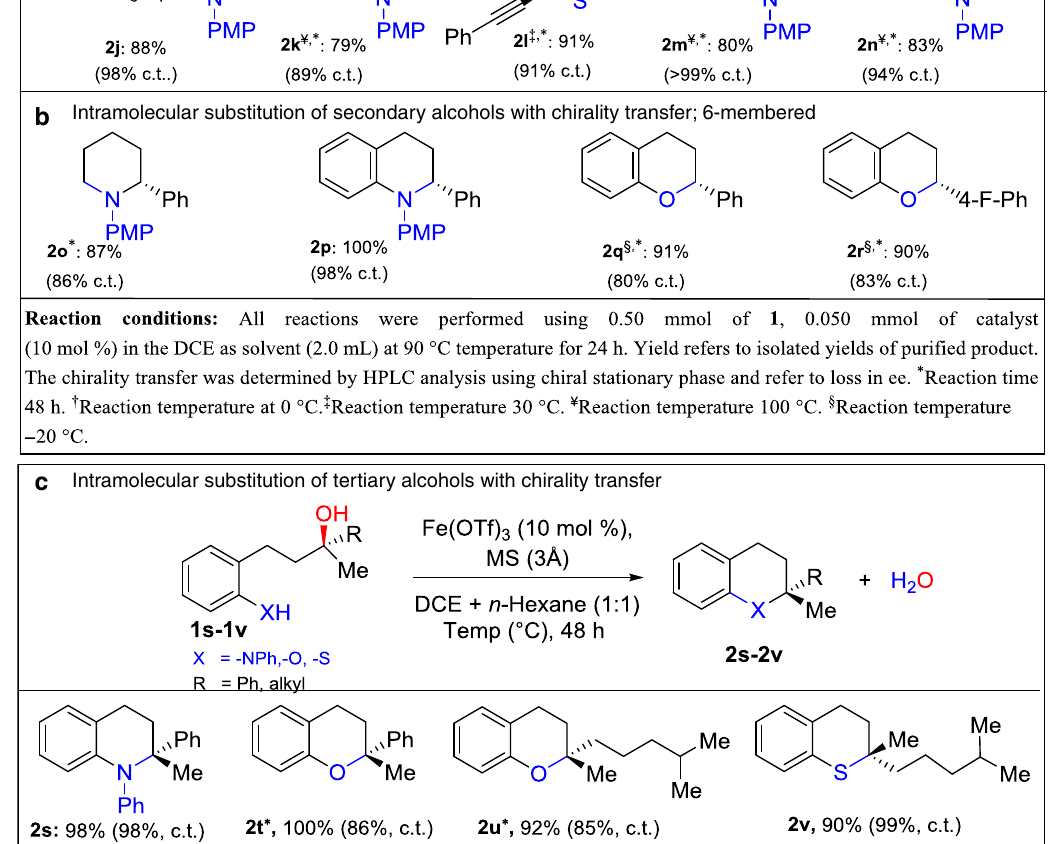
Fig. 2 Intramolecular substitution of the OH group of alcohols with chirality transfer. a , b General reaction scheme, products obtained, and reaction conditions for the intramolecular substitution of secondary alcohols with chirality transfer to fi ve-membered and six-membered rings, respectively. c General reaction scheme, products obtained, and reaction conditions employed in the intramolecular substitution of tertiary alcohols with chirality